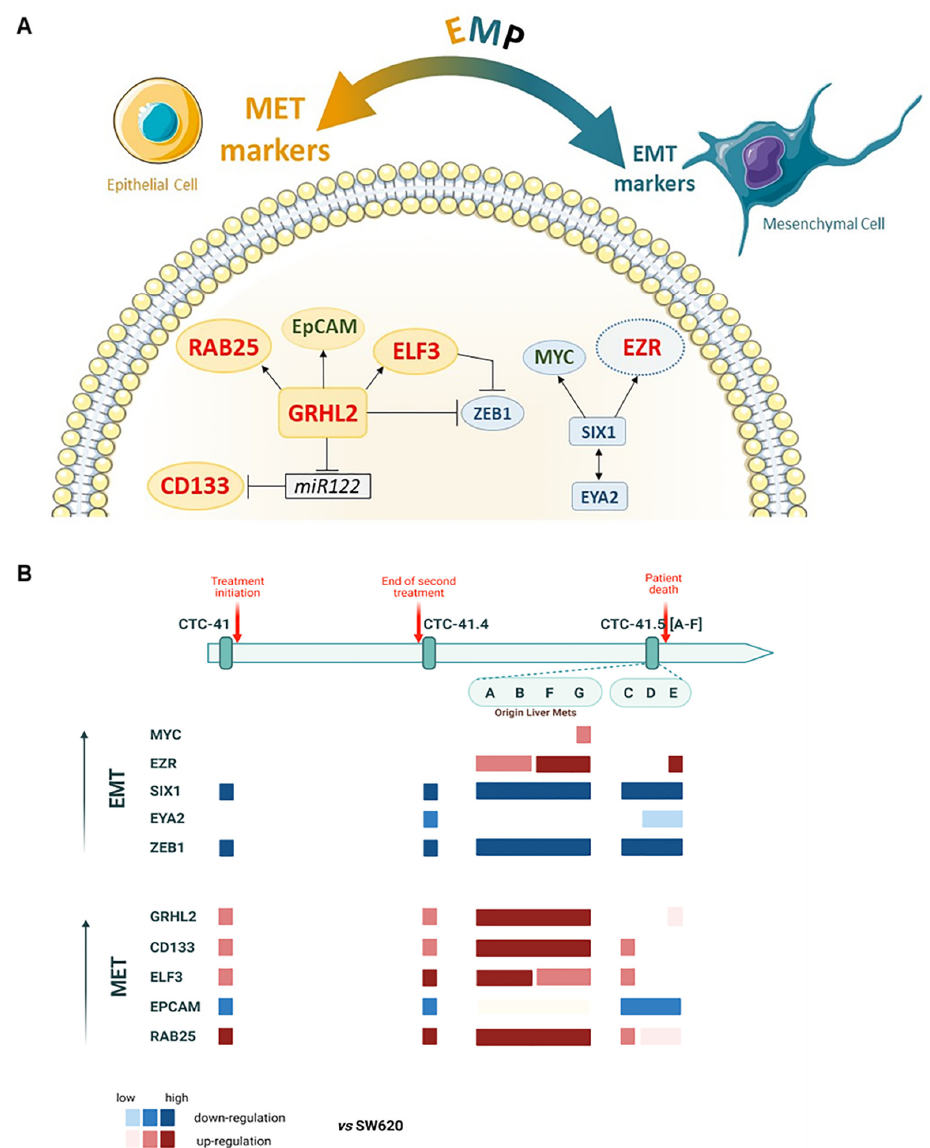
Figure 6. Schematic presentation of EMP marker expression in the nine serial CTC lines. ( A ) Network and regulations; in red, significantly upregulated genes (>2-fold change in log2); in green, upregulated genes but without significant difference; in blue, genes significantly downregulated in the nine CTC lines compared with the metastatic colorectal cancer SW620 cell line. ( B ) Upregulation of EMT (in blue) and MET (in red) markers in each CTC line, compared to SW620, showing the EMP profile during disease progression and